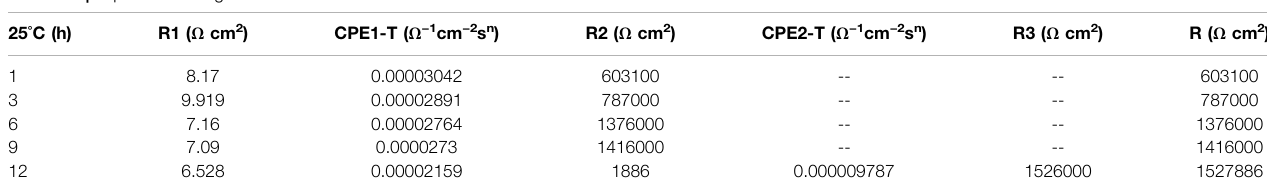
TABLE 6 | Impedance fi tting data of the heat affected zone soaked in arti fi cial seawater at 25 ° C for 12 h 25 ° C